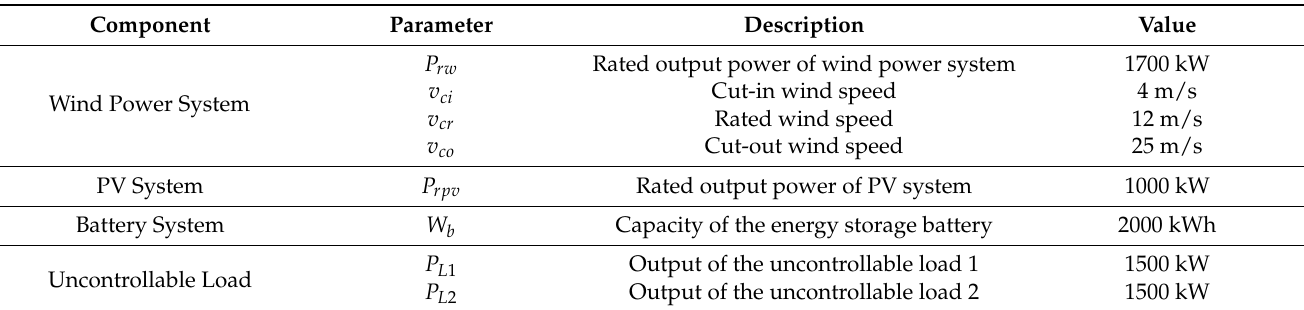
Table 5. Main parameters of microgrid.